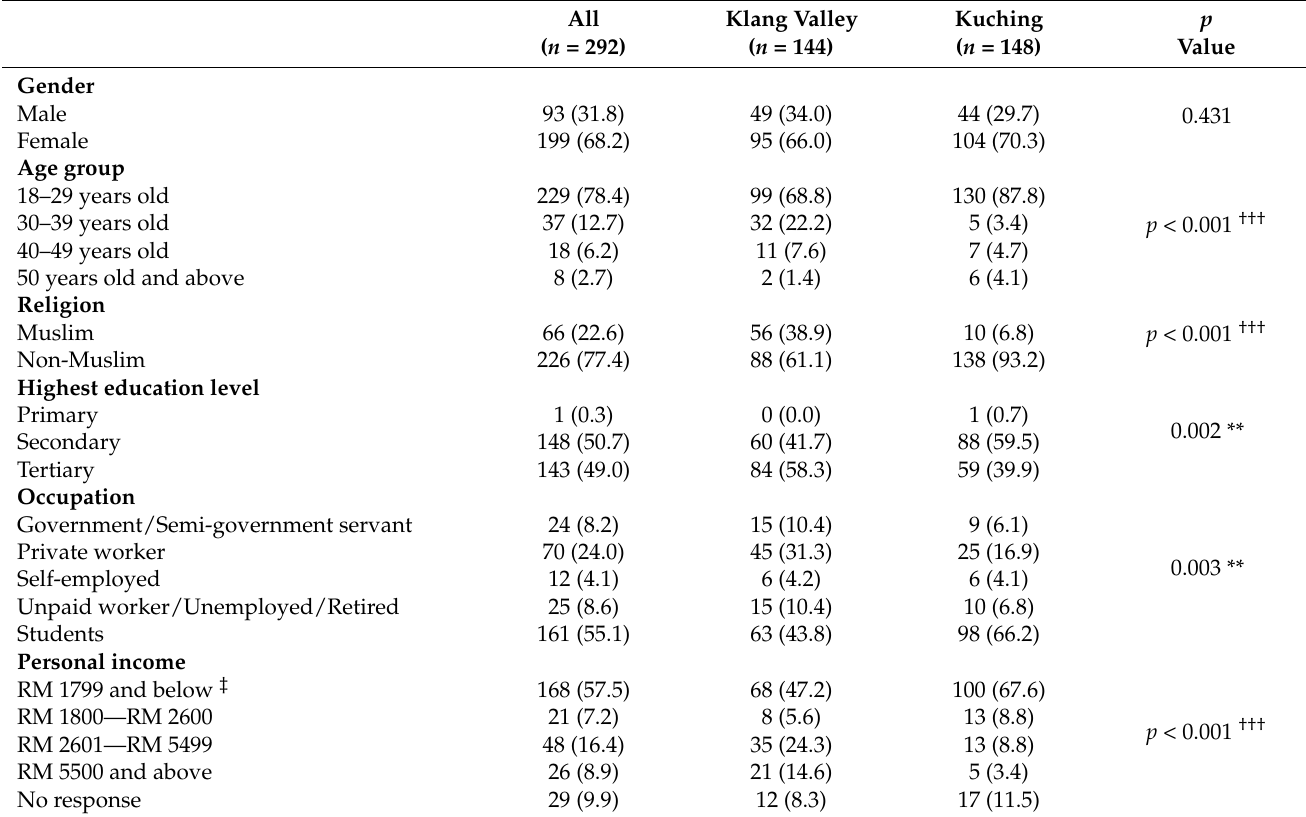
Table 1. Sociodemographic characteristics of the respondents according to the study location, n (%). All Klang ( n = 292)